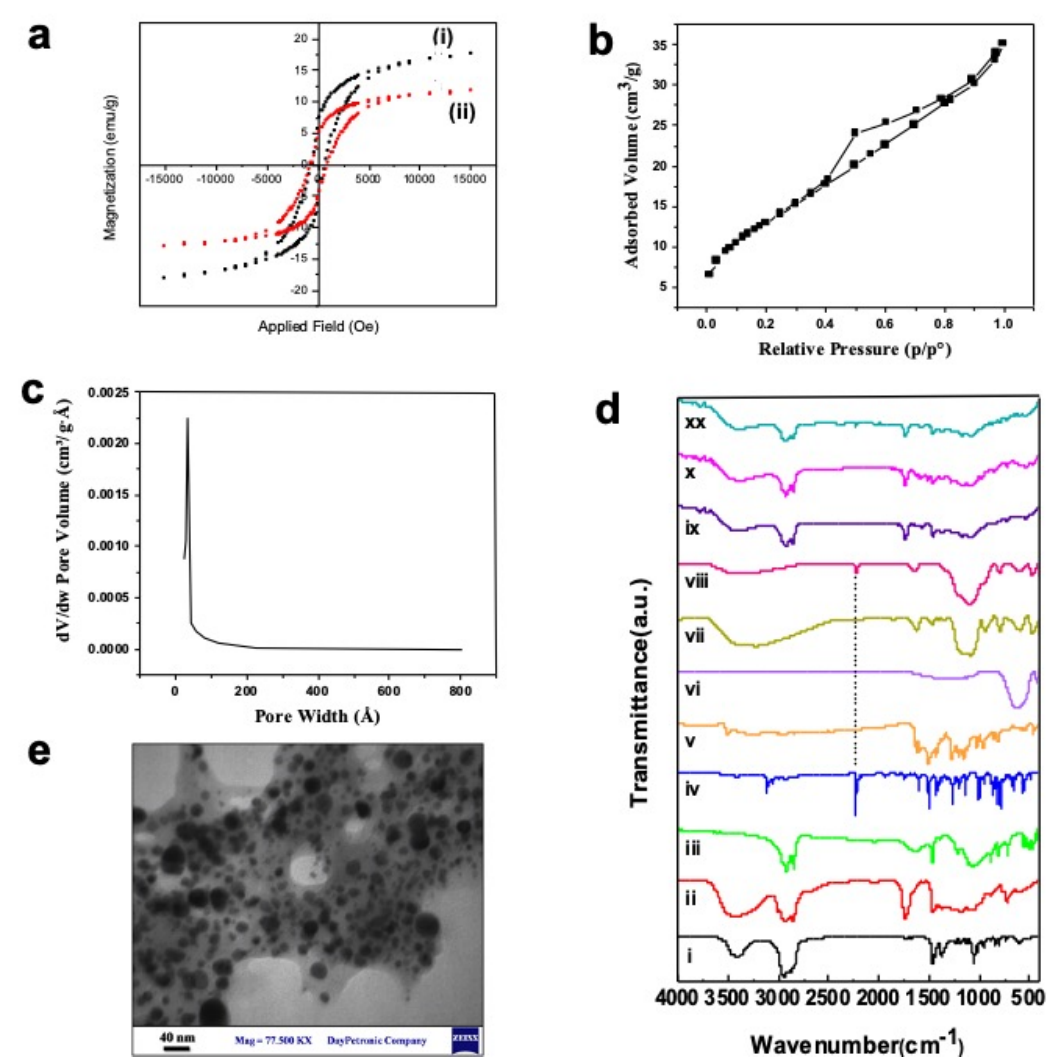
Figure 1. ( a ) Magnetic properties of NiCoFe 2 O 4 nanoparticles (i) and NiCoFe 2 O 4 @Silica nanoparticles (ii); ( b ) nitrogen adsorption–desorption isotherms of the mesoporous NiCoFe 2 O 4 @Silica; ( c ) pore size distribution for NiCoFe 2 O 4 @Silica nanoparticles. ( d ) Fourier transform infrared (FTIR) spectra of (i) cholesterol, (ii) span 80, (iii) DCP, (iv) letrozole, (v) curcumin, (vi) NiCoFe 2 O 4 , (vii) NiCoFe 2 O 4 @Silica, (viii) NiCoFe 2 O 4 @L-Silica, (ix) NiCoFe 2 O 4 @L-Silica@Niosome, (x) NiCoFe 2 O 4 @L-Silica@C-Niosome, and (xx) NiCoFe 2 O 4 @L-Silica@L-Niosome; ( e ) TEM image for NiCoFe 2 O 4 @Silica@Niosome nanocarriers.